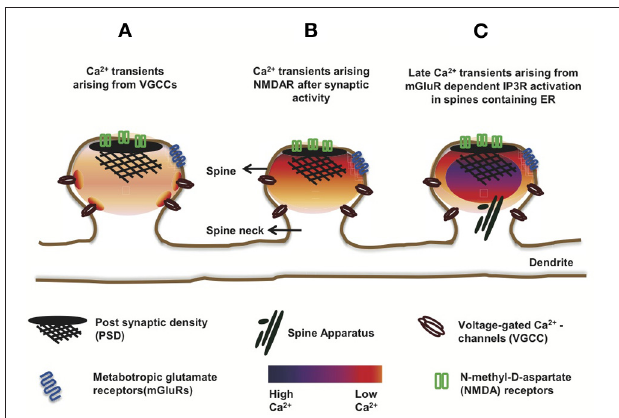
FIGURE 3 | Ca 2 + transients in dendritic spines. The schematic shows mushroom spines displaying variability in the amplitudes and spatial patterns of Ca 2 + transients, depending on the type of ion channels involved. (A) Opening of VGCCs leads to a fast rise and decay of Ca 2 + -transients in the spine. Except near the mouth of the channel where [Ca 2 + ] reaches a very high level, the distribution of the ion is largely uniform, reflecting the uniform distribution of VGCCs over the spine membrane. (B) Activated NMDARs allow slower, larger, and longer-lasting Ca 2 + -transients than the VGCCs. Unlike the latter, NMDARs are clustered at the PSD. Therefore, the Ca 2 + -transients arising from NMDARs show a stronger spatial gradient than the transients arising from open VGCCs. (C) In a subset of ER-containing spines, delayed Ca 2 + -transients with several folds higher amplitude than the NMDAR-mediated ones, have been observed and attributed to mGluR-dependent Ca 2 + -induced Ca 2 + release (CICR) from IP3Rs, located on ER